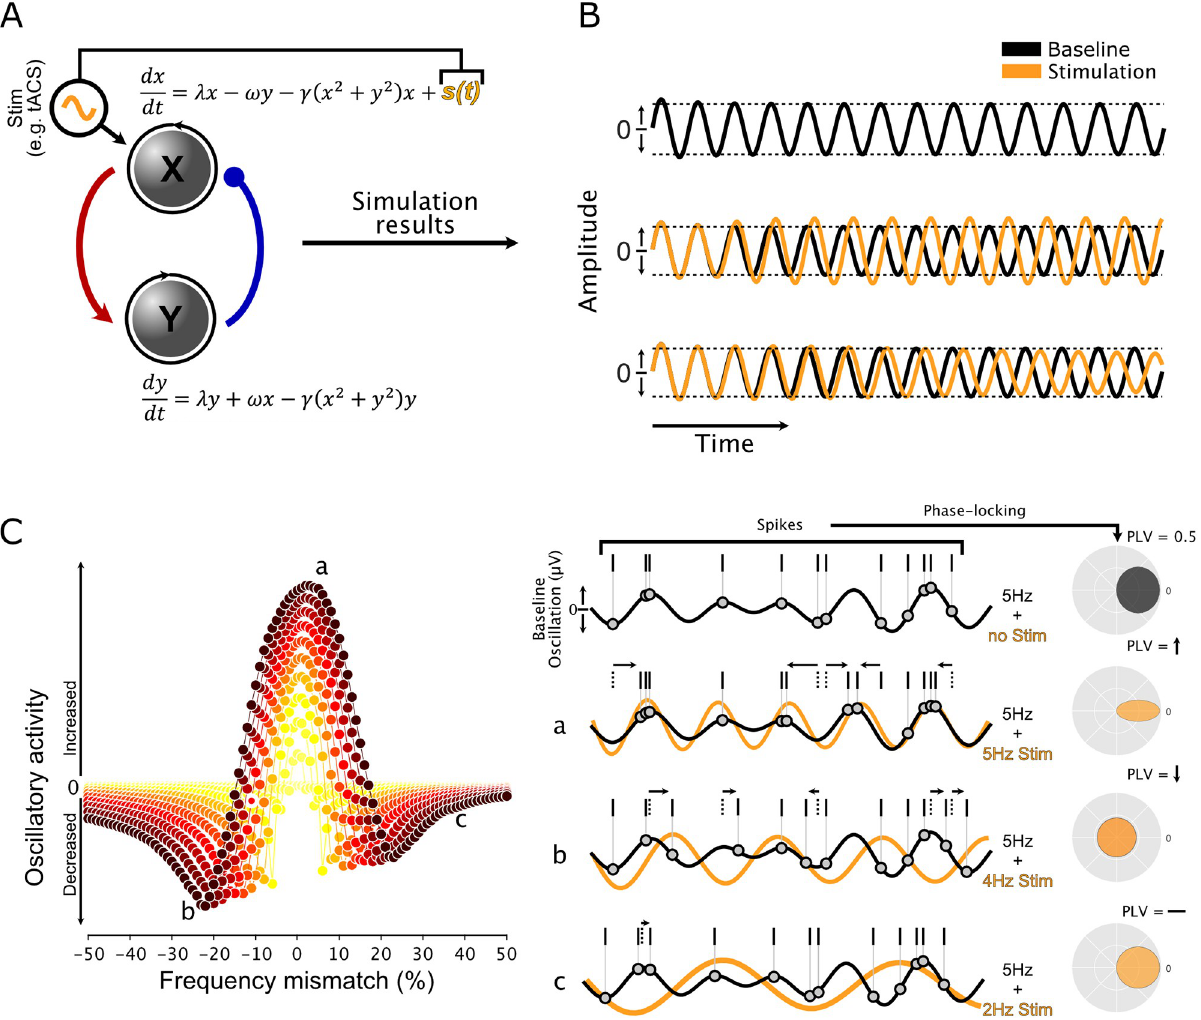
Fig 3. Simple oscillator models can account for the varied effects of tES. (A) The Stuart–Landau oscillator model consists of 2 interacting populations, much like the sensor-furnace model in Fig 2. Without external stimulation, the model oscillates continuously at a fixed frequency and amplitude (top). Applying a sinusoidal input to one population can increase (middle) or decrease (bottom) the oscillation’s amplitude, depending on the strength of the ongoing oscillation. See [12,27] for more details. (B) Interactions between the stimulation intensity and frequency relative to the ongoing oscillation can therefore generate a multitude of outcomes (left). The same pattern is evident in our neural data (right), where some combinations (a) increase entrainment between spikes and the EEG (b) decrease it, or (c) have no effect in that frequency range. Panel B adapted from [14]. EEG, electroencephalogram; tES, Transcranial electrical